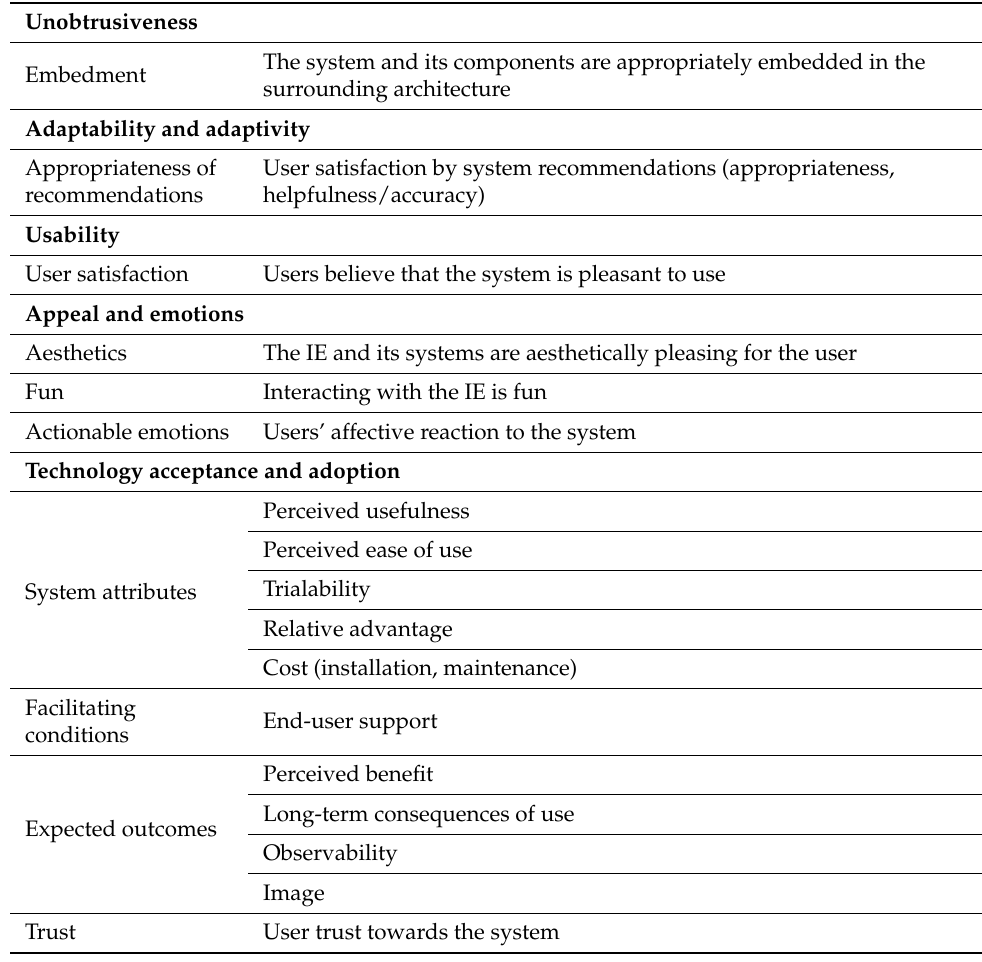
Table A5. UXIE metrics to be assessed through questionnaires shortly after a user-based study.